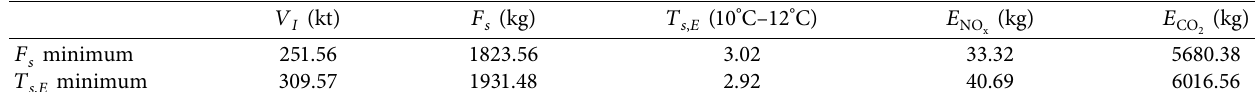
Table1: Parameters corresponding to F